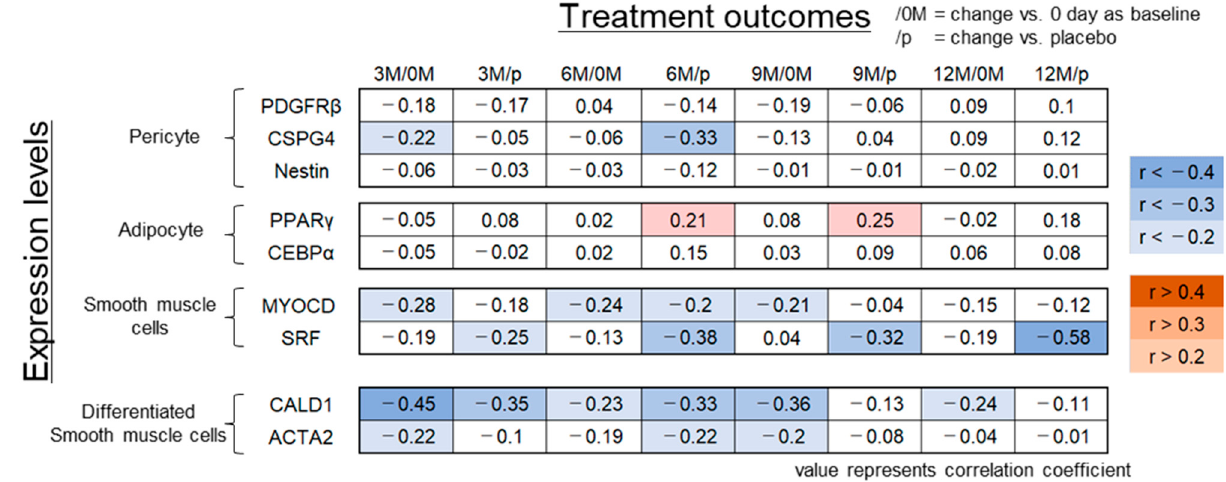
Figure 1. Correlation analysis between treatment outcome scores at each time point during the clinical study using DSC cell lines [21] and expression levels of differentiation markers. The results of correlation analysis between the treatment outcome score at 3, 6, 9, and 12 months vs. that at 0 day (3 M/0 M, 6 M/0 M, 9 M/0 M, and 12 M/0 M) or vs. the placebo (3 M/p, 6 M/p, 9 M/p, and 12M /p) and the expression levels of the indicated differentiation markers are shown. Each value represents the correlation coefficient. Red: positive correlation; blue: inverse correlation.